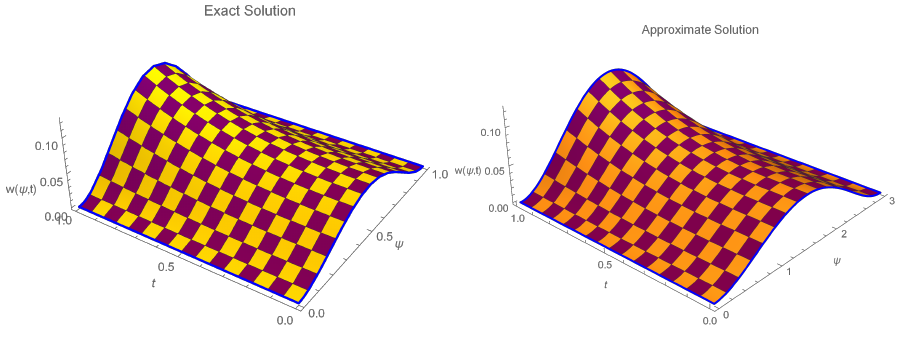
Figure 6. Absolute error of Example 2 obtained by the proposed scheme when ˜ M = 100, K = 10.